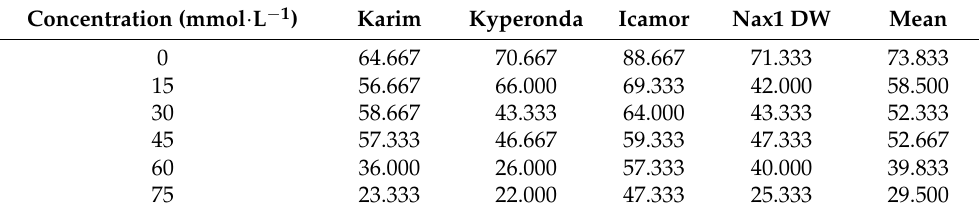
Table 1. GP for four durum wheat genotypes under different concentrations of salt.